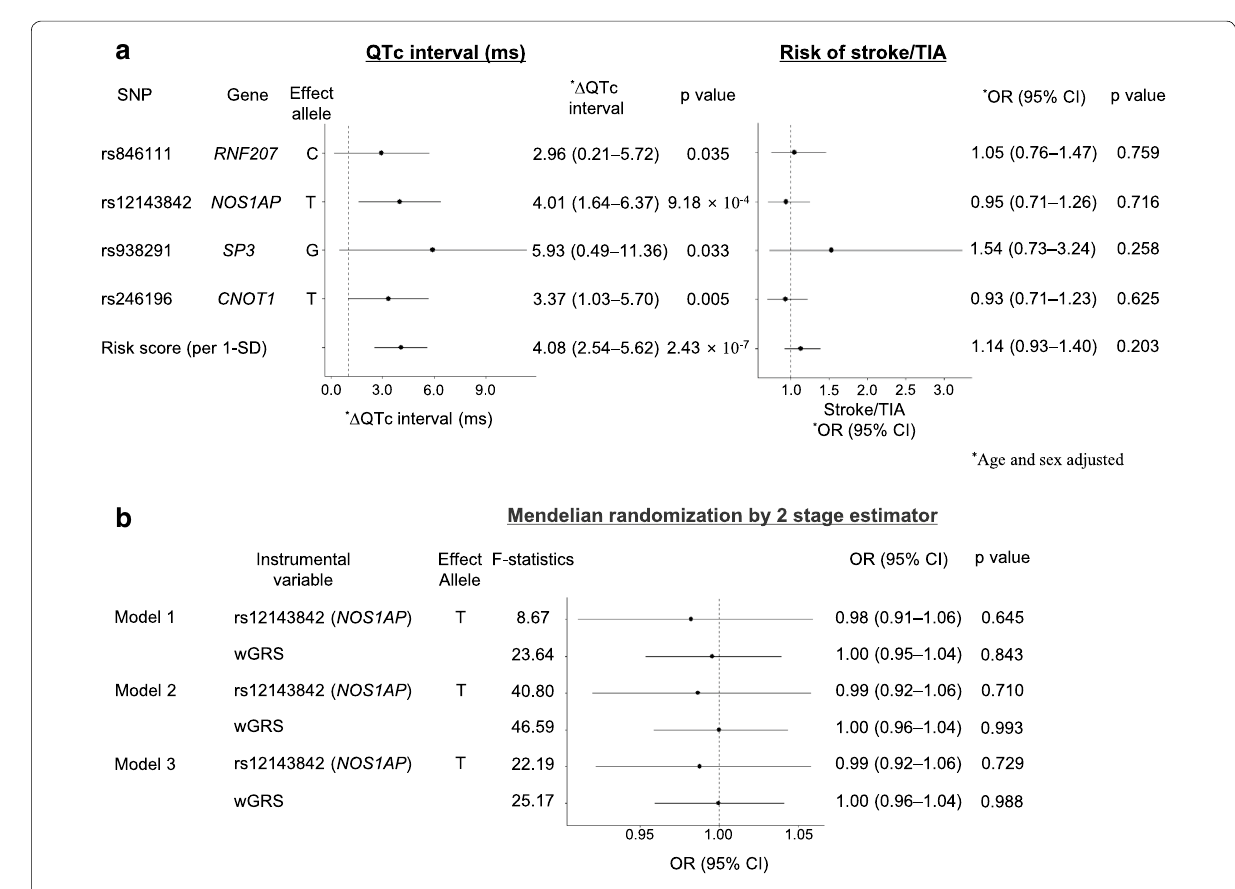
Table 4 Two-sample Mendelian randomization estimates of the causal effect of QT interval on cardioembolic stroke